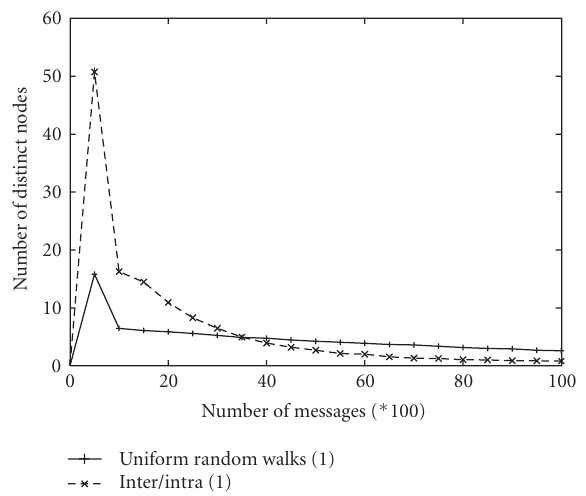
Figure 11: The number of distinct nodes discovered in the same group within a certain message range.